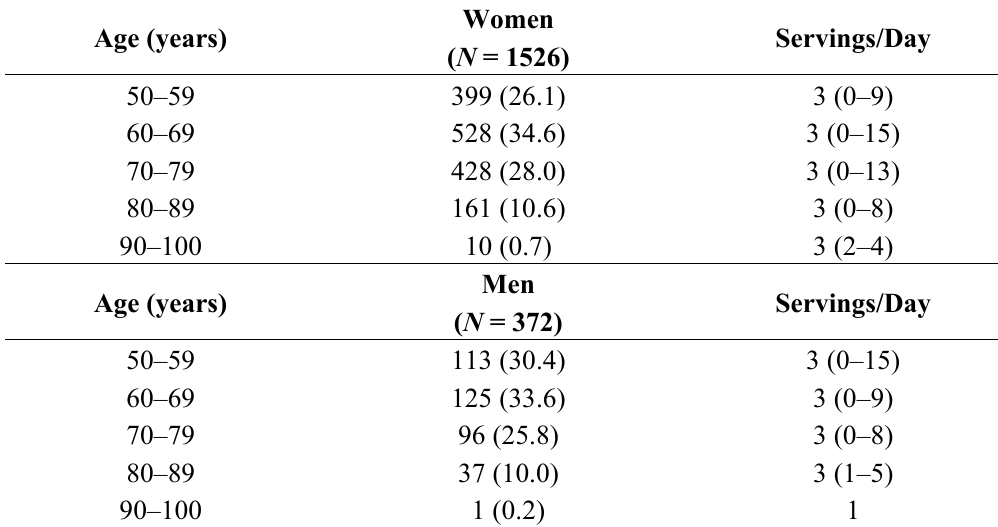
Table 4. Number of daily servings of dairy products in females and males distributed into five age decades.